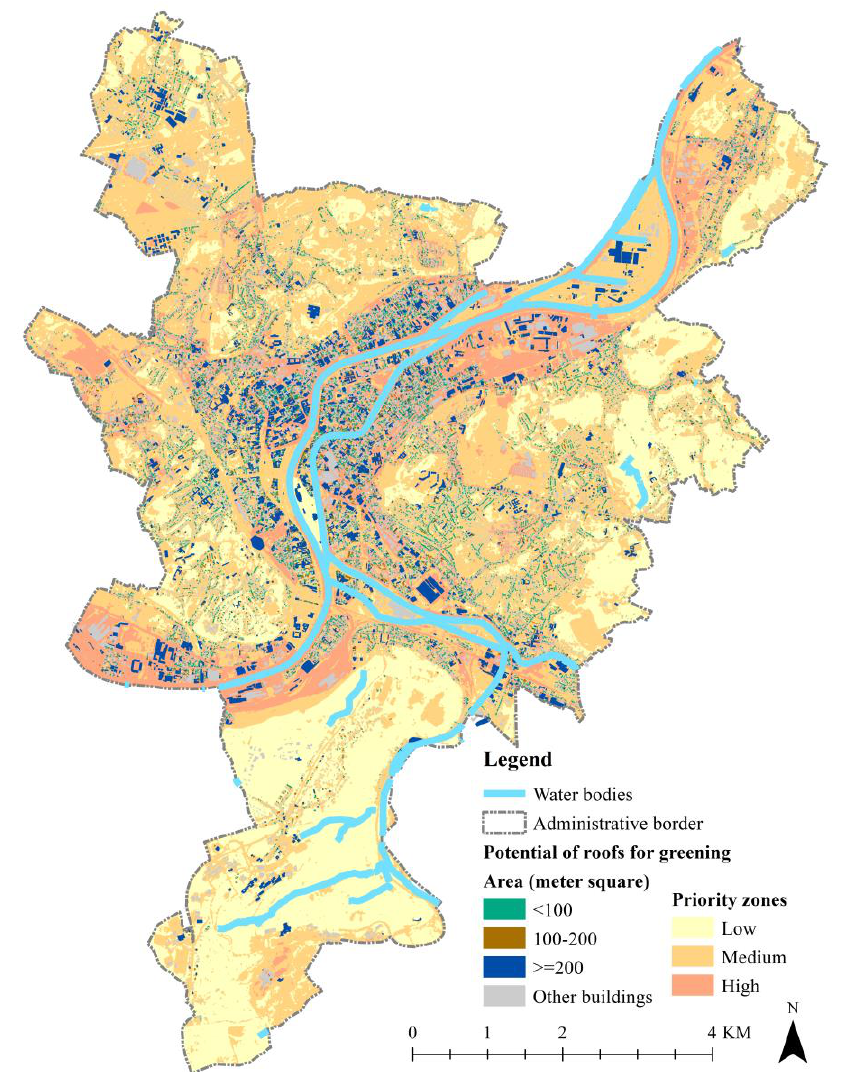
Figure 5. Potential of green roofs in the city of Liege along with priority